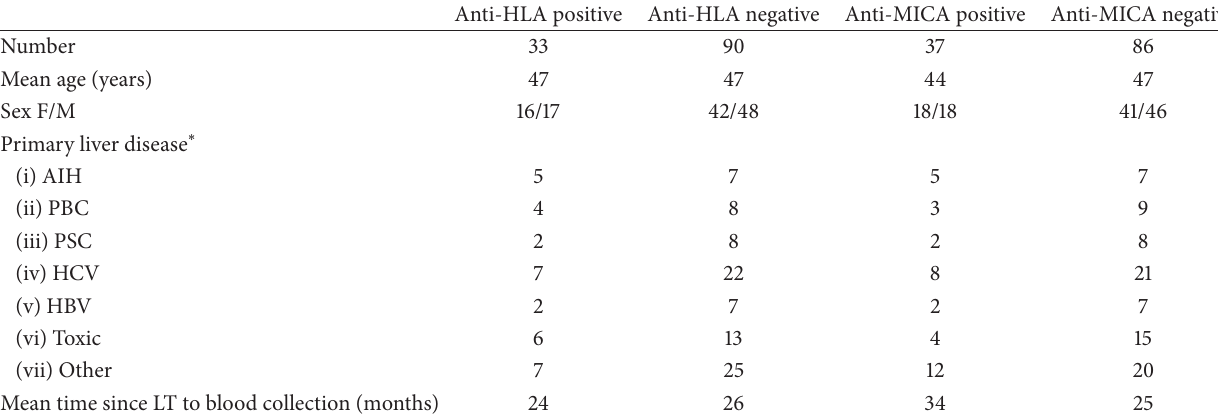
Table 1: Patients characteristics.